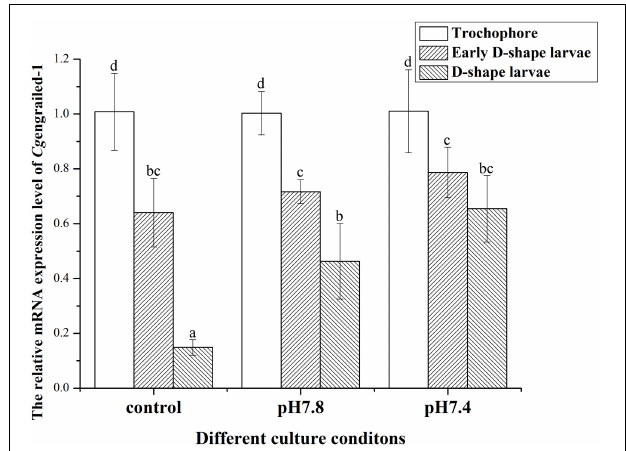
FIGURE 3 | Changes of Cg engrailed-1 mRNA expression in trochophore, early D-shape larvae and D-shape larvae under acidification treatment. Each value was shown as mean ± SD ( N = 3), and statistical significance ( p < 0.05) was marked by different letters